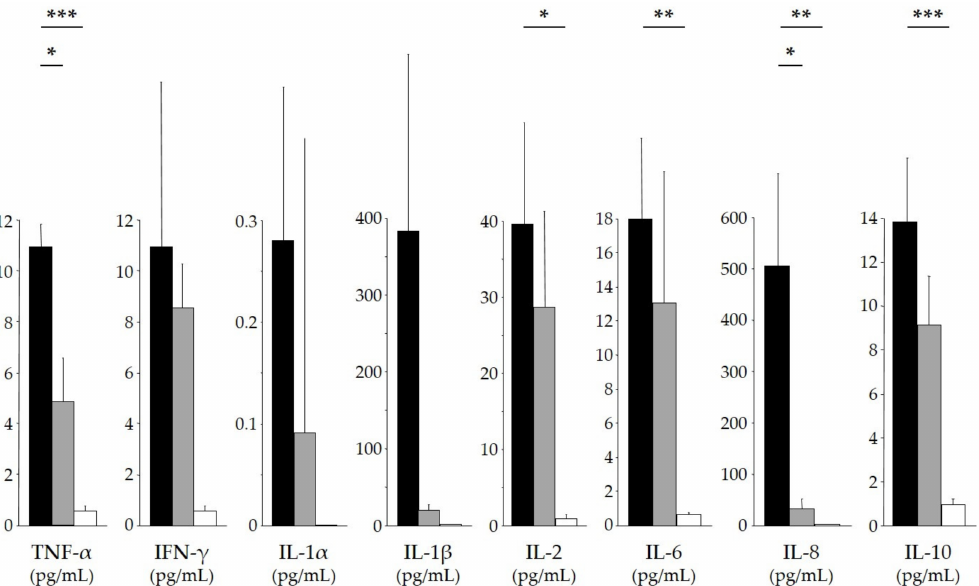
Figure 3. Serum cytokine levels in SAGN with IgA-dominant deposition. Sera were obtained from patients with SAGN S. aureus -infected patients without glomerulonephritis and healthy controls, and the following 10 cytokines were measured by enzyme-linked immunosorbent assays: IL-1 α , -1 β , IL-2, IL-4, IL-6, IL-8, IL-10, TNF- α , TNF- β , and INF- γ [9–13]. The serum levels of eight cytokines are shown. Black closed bars : the mean levels of cytokines in patients with SAGN. Gray closed bars : the mean levels of cytokines in S. aureus -infected patients without glomerulonephritis. Open bars : the mean levels of cytokines in healthy controls. Bars : the standard deviation. Serum levels of IL-2, IL-6, IL-8, IL-10, and TNF- α in the patients with SAGN were significantly higher compared to those in the controls, and serum levels of IL-8 and TNF- α in the patients with SAGN were significantly higher compared to those in patients without glomerulonephritis (* p < 0.05; ** p < 0.01; *** p < 0.001). Serum IL-4 and TNF- β were not detected in all three